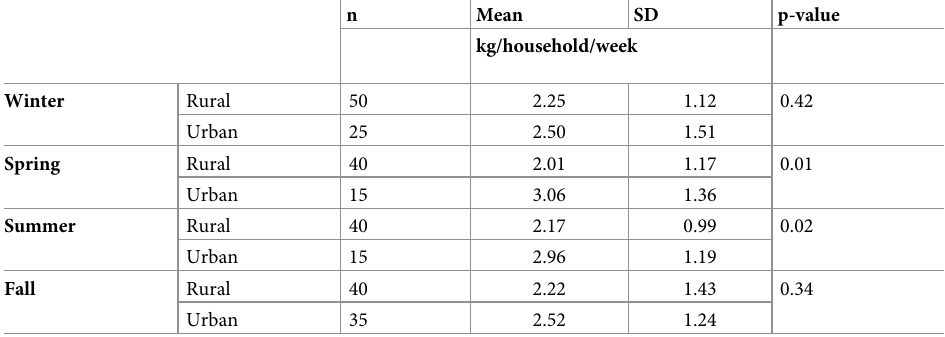
Table 2. Food waste disposal by season and sampling area type.